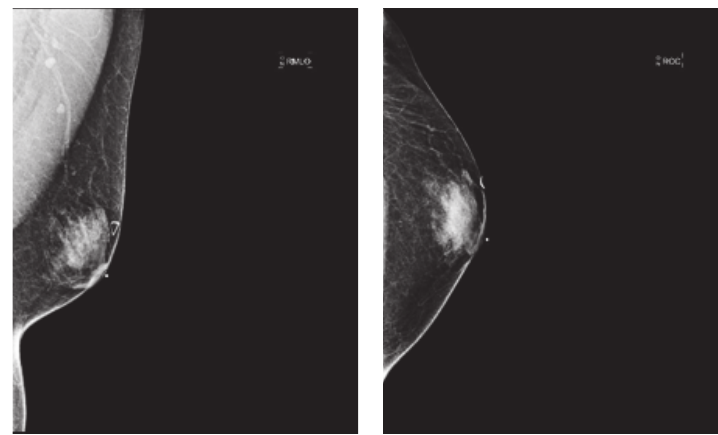
Figure 1: Mammogram of right breast.